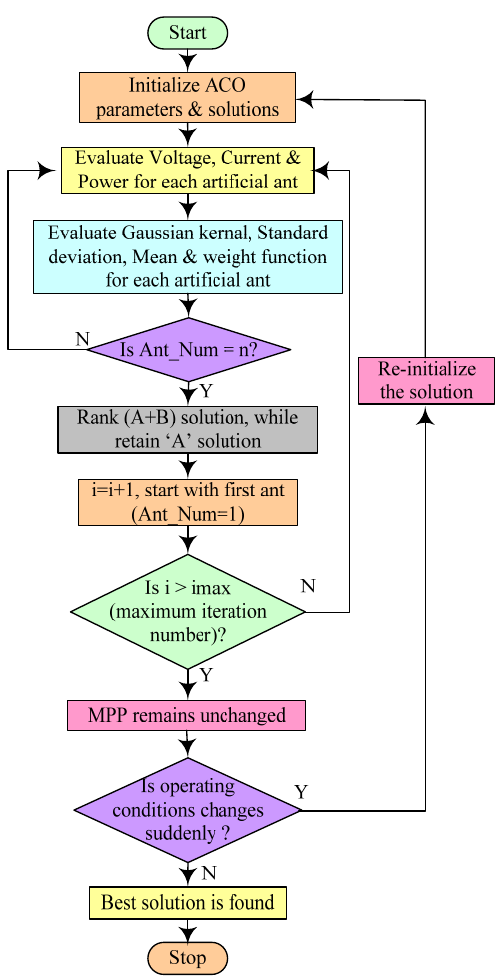
Figure 12. ACO-based MPPT technique [47].